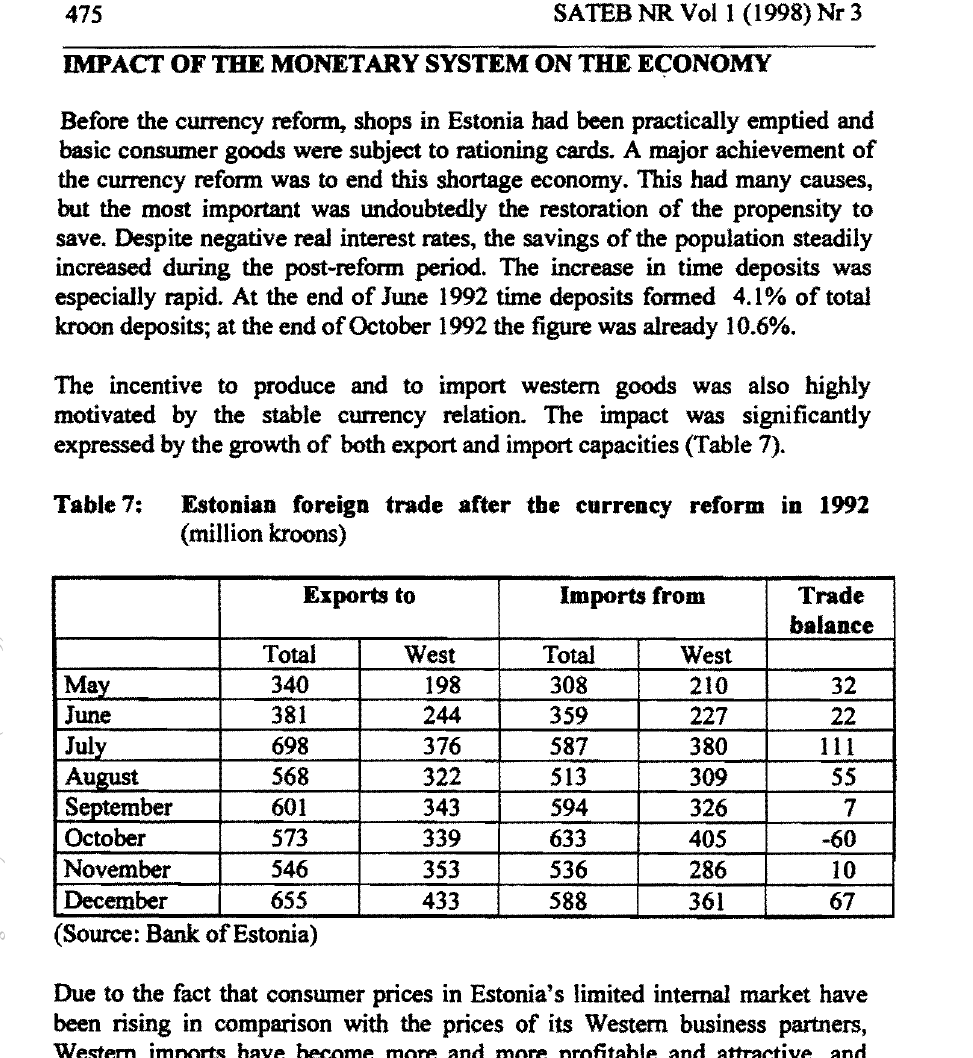
Estonian foreign trade after the currency reform in 1992 (million !croons) Exports to Imports from Trade Total West Total